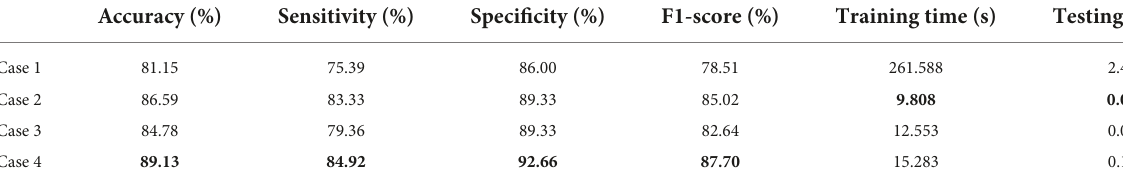
TABLE 5 Performance comparison for the four different cases.